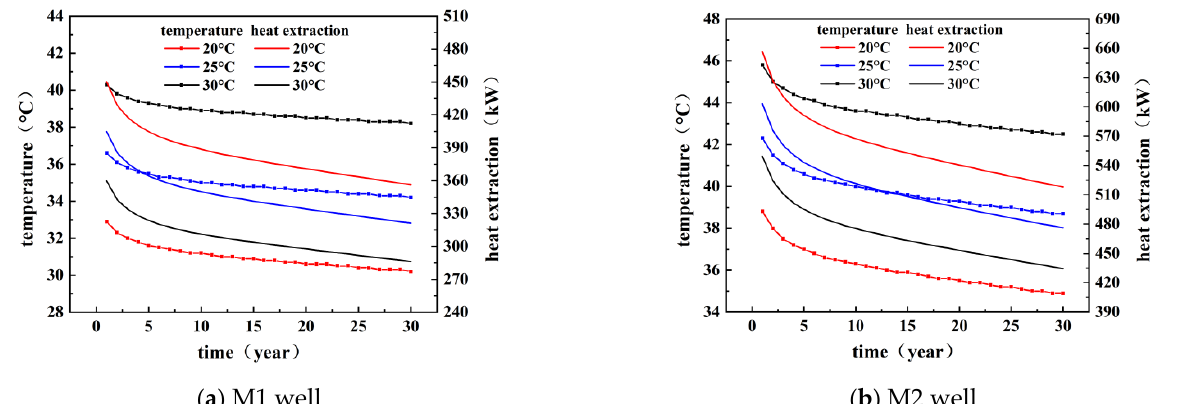
Figure 6. Comparison of production temperature and heat extraction at different injection temperatures.